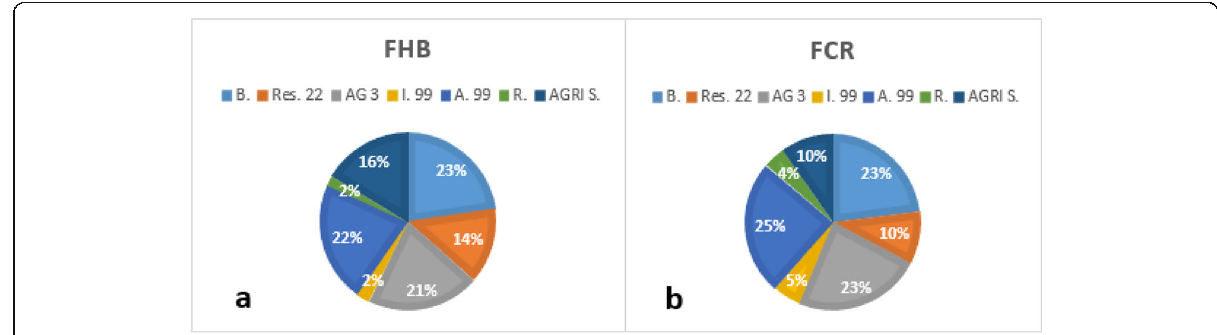
Fig. 5 The disease incidence percentage of FHB ( a ) and FCR ( b ) on the seven cultivars planted in the 14 selected wheat fields in the south of Iraq/Basra